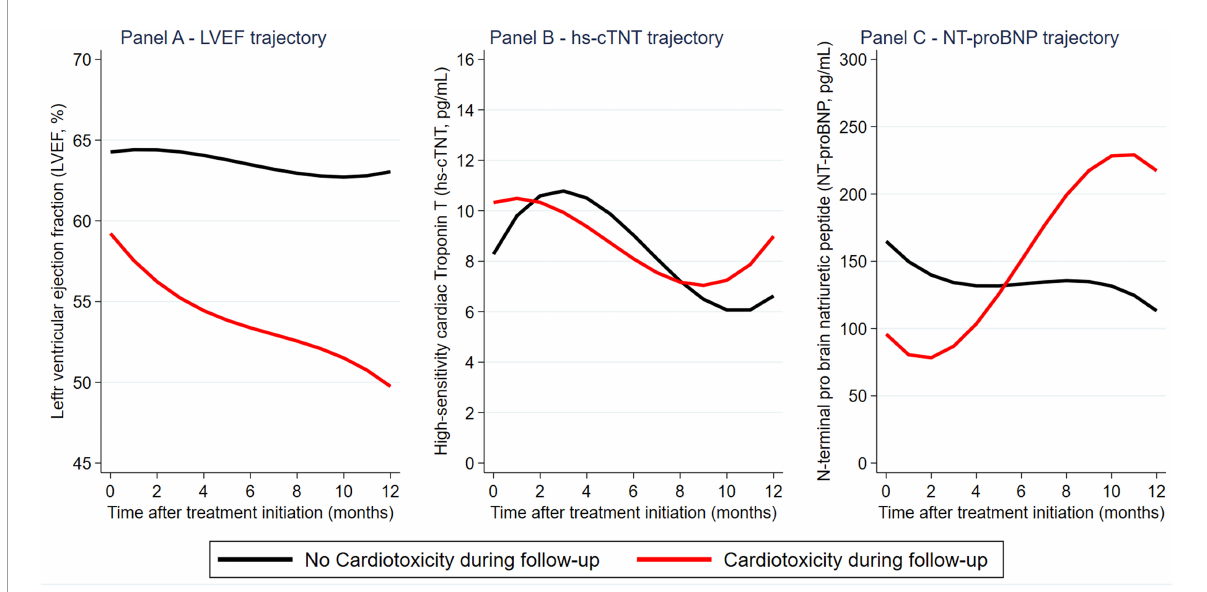
FIGURE2 Longitudinal evolution of left ventricular ejection fraction (LVEF), hs-cTnT, and NT-proBNP during trastuzumab-based therapy: Distribution by cardiotoxicity outcomes. Reported graphs are from marginal means predicted at monthly intervals from a mixed effects